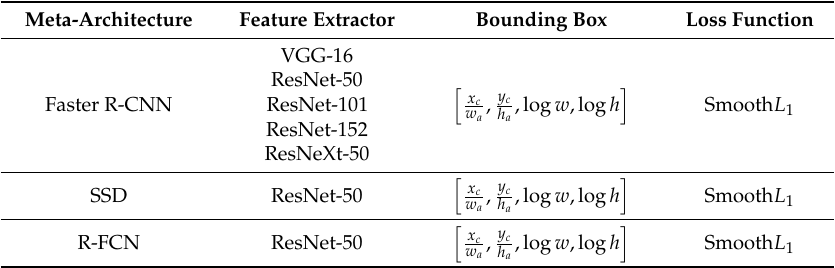
Table 2. Details of Deep Learning Meta-architectures and Feature Extractors.